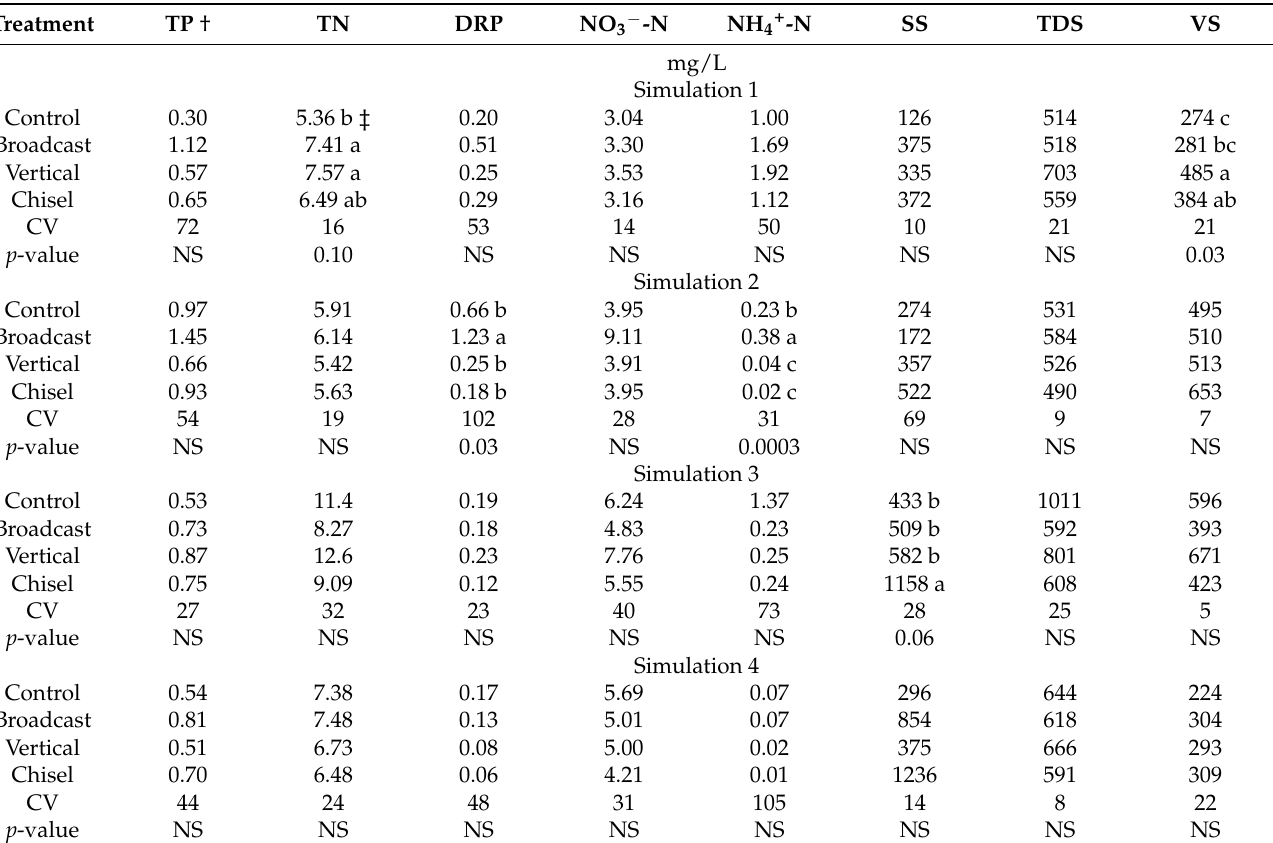
Table 3. Concentrations in runoff for each